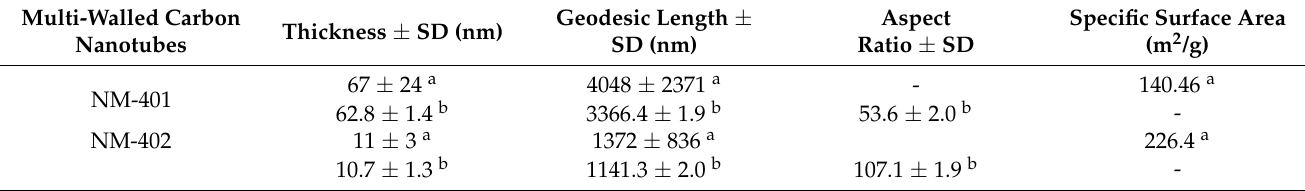
Table 1. Properties of MWCNT under